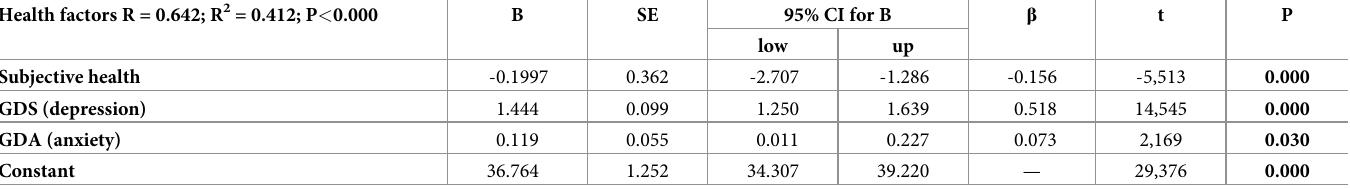
ments, self-esteem, sense of coherence, lower age, and better social support assessments). Table 3. Multiple regression analysis with the health factors as independent variables and the life satisfaction as dependent variables (model 1). Health factors R = 0.642; R 2 = 0.412; P <